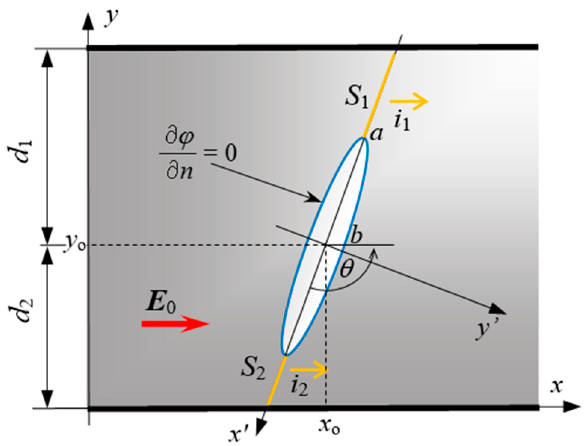
Figure 3. Analyzed model of a conductive layer with an elliptical defect.